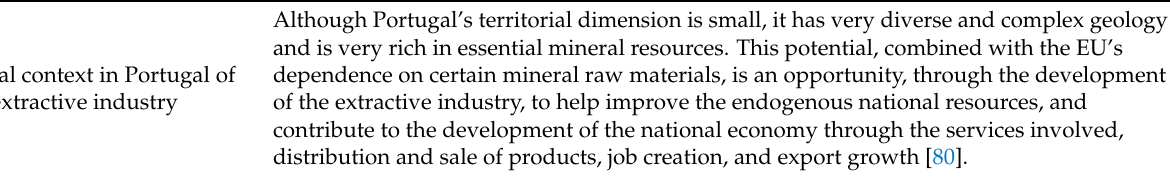
Table 4. Sectoral context and description of the case